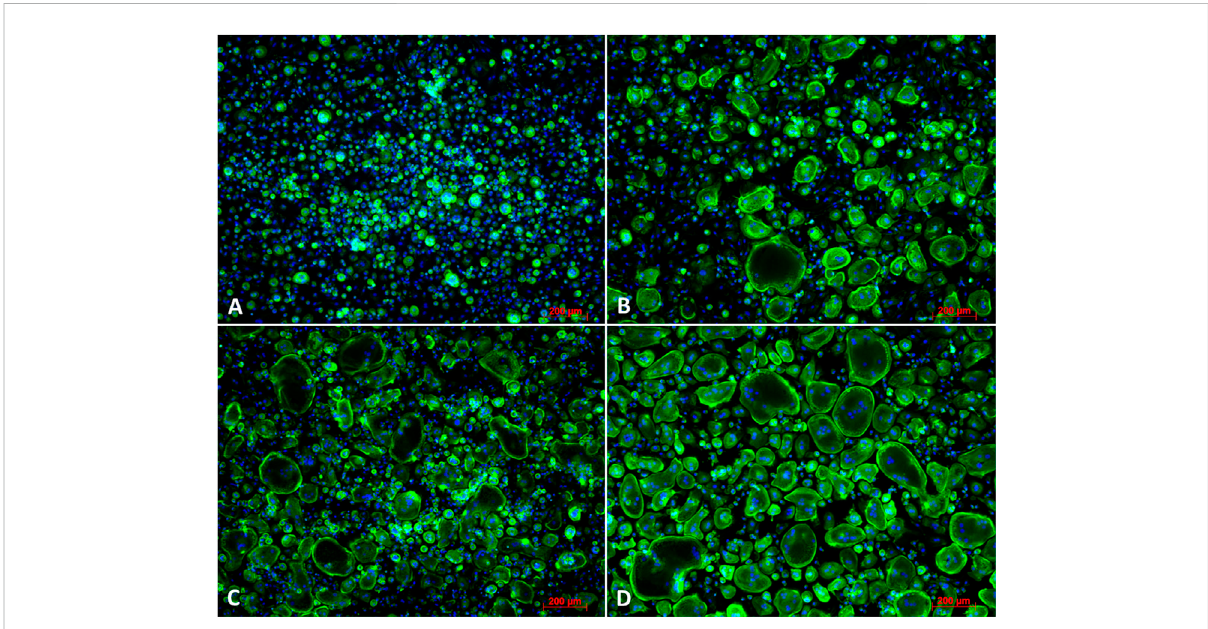
FIGURE 10 Fluorescence images of osteoclast differentiation. PBMCs were incubated (A) with M-CSF (negative control); (B) with M-CSF+ RANKL (positive control); (C) with M-CSF + RANKL + secretome (10x) of JPCs incubated with osteogenic medium without dexa (JPC_OB − D); (D) with secretome (10x)ofJPCsincubatedwithosteogenicmediumwithdexa(JPC_OB+D).Cellswereincubatedwithdifferentmediasupplementationsfor6daysand then fi xed and stained for actin (phalloidin-alexa fl uor 488) and nuclei (Hoechst). Scale bars = 200